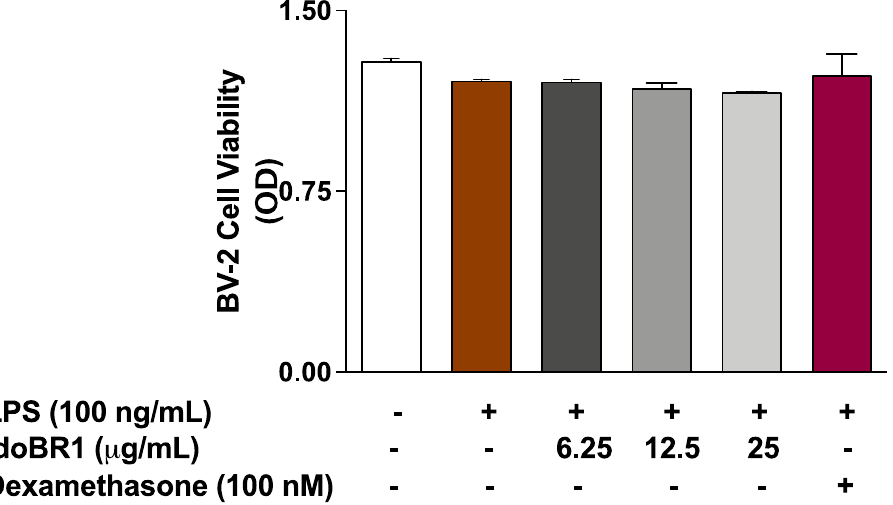
Figure 4. MTT assay showing effects of idoBR1 (6.25, 12.5, and 25 µg/mL) and dexamethasone (100 nM) on the viability of BV-2 microglia stimulated with LPS (100 ng/mL) for 24 h.